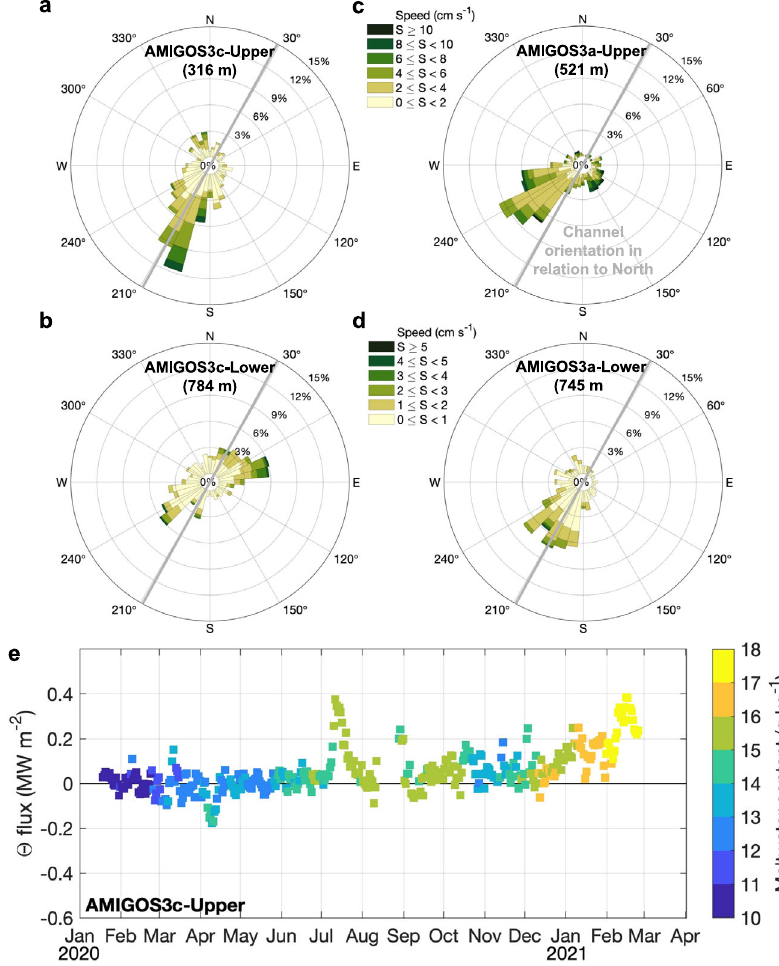
Fig. 4 | Ocean current variability and temperature fl ux. Current-rose by occur- rence for different speeds and directions for a AMIGOS3c-Upper, b AMIGOS3c- Lower, c AMIGOS3a-Upper, and d AMIGOS3a-Lower. The mean depth of each sensor is shown in parentheses. Note that the speed scale varies between Upper